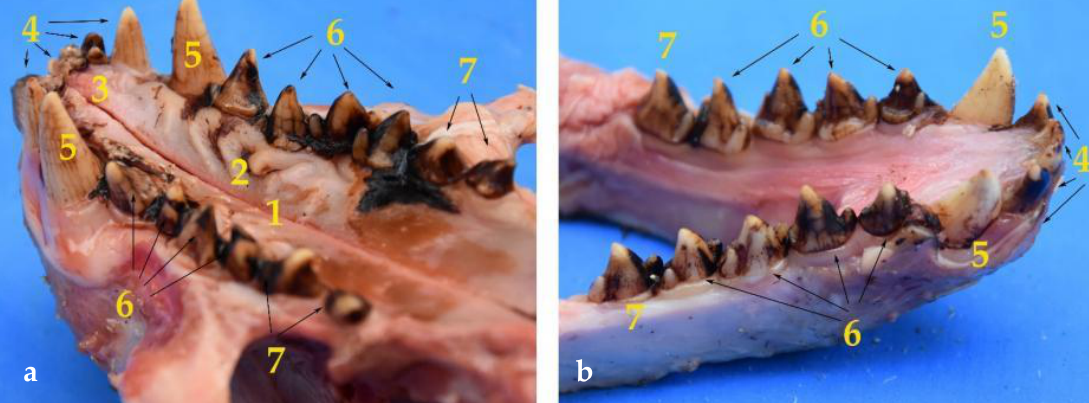
Figure 3. Images of the palate and teeth of the maxilla ( a ) and the jaw ( b ), which are composed of: ( 1 ) Hard palate; ( 2 ) palatine ridges; ( 3 ) incisive papilla; ( 4 ) incisors; ( 5 ) canines; ( 6 ) premolars; ( 7 ) molars. Additionally, the images show the substantia nigra adhered to the teeth surface.